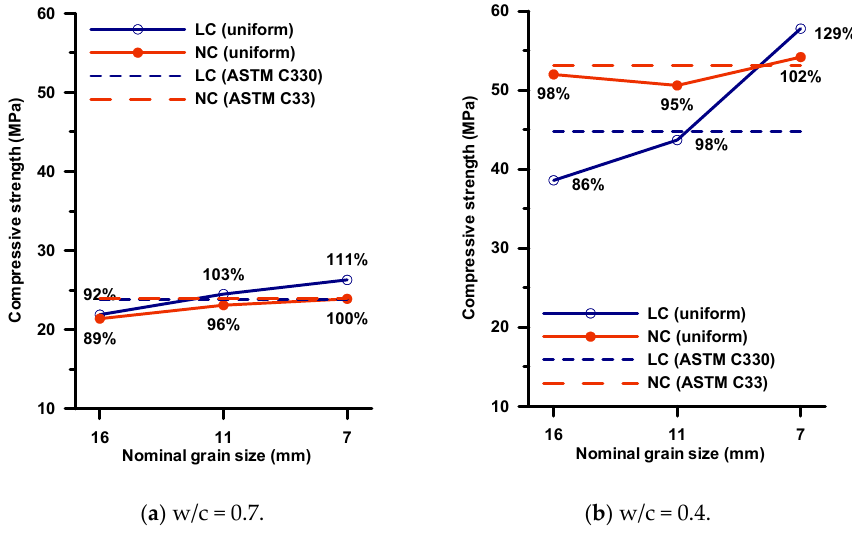
Figure 6. Compressive strength of NWC and LWAC